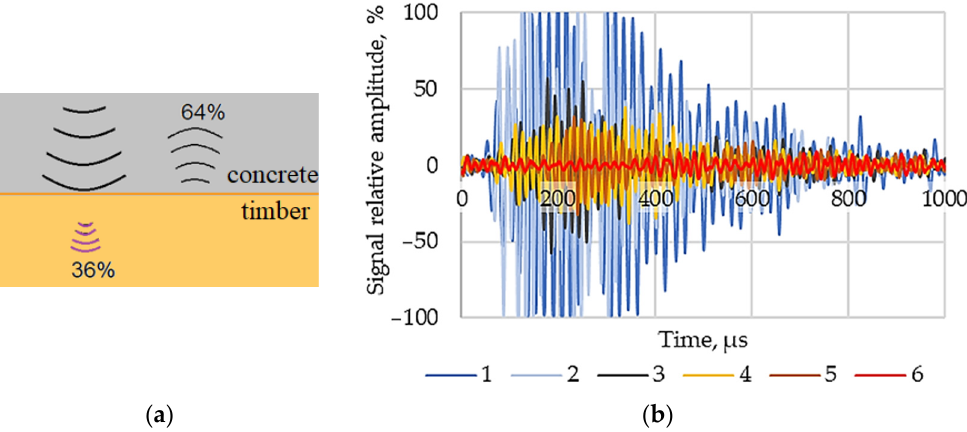
Figure 8. ( a ) Ultrasonic wave reflection and transition from concrete material to timber; ( b ) measurement records from ultrasound testing at different specimen locations (1–6 according to Figure 4a).